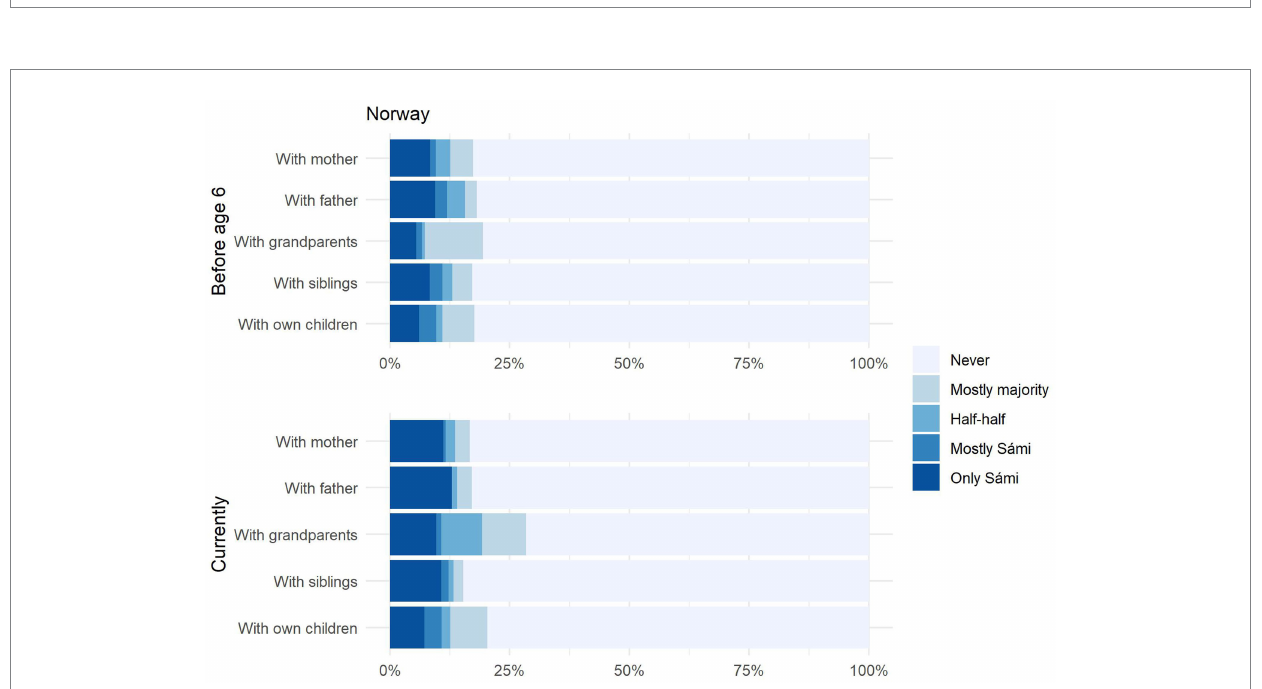
FIGURE 6 Norway: Amount of Sámi spoken by family member before starting school vs.